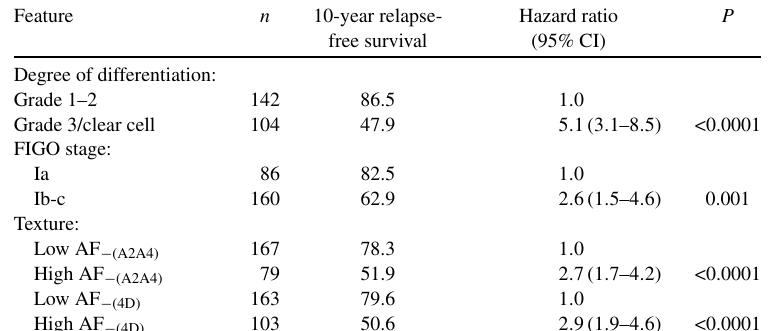
Relapse-free survival related to histological grade (including clear cell tumors in the group of poorly differentiated tumors), FIGO stage, and texture analysis by the adaptive features AF − (A2A4) and AF − (4D) in stage I ovarian cancer. The complete data set (246 cases) was included in